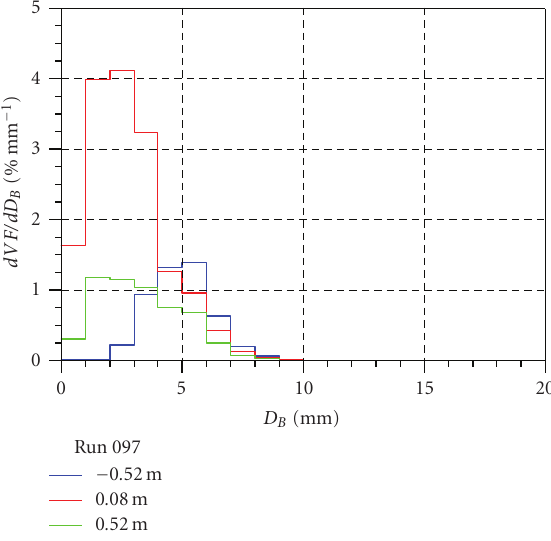
Figure 9: Bubble size distributions for run 096 ( J L = 1 . 017 m/s, J G = 0 . 0898 m/s) (CFX) ( F B = F C = 0 . 05).